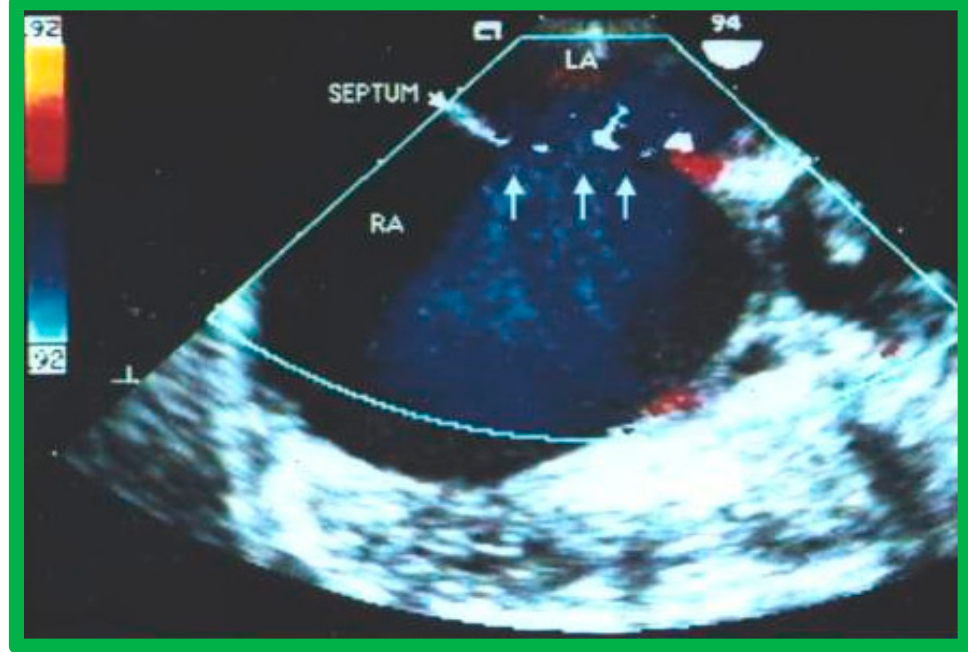
Figure 19. Transesophageal echocardiographic study of a fenestrated atrial septal defect in short projection demonstrating left-to-right shunt across a fenestrated atrial defect (arrows). LA, Left atrium; RA, right atrium. Reproduced from Reference [4].